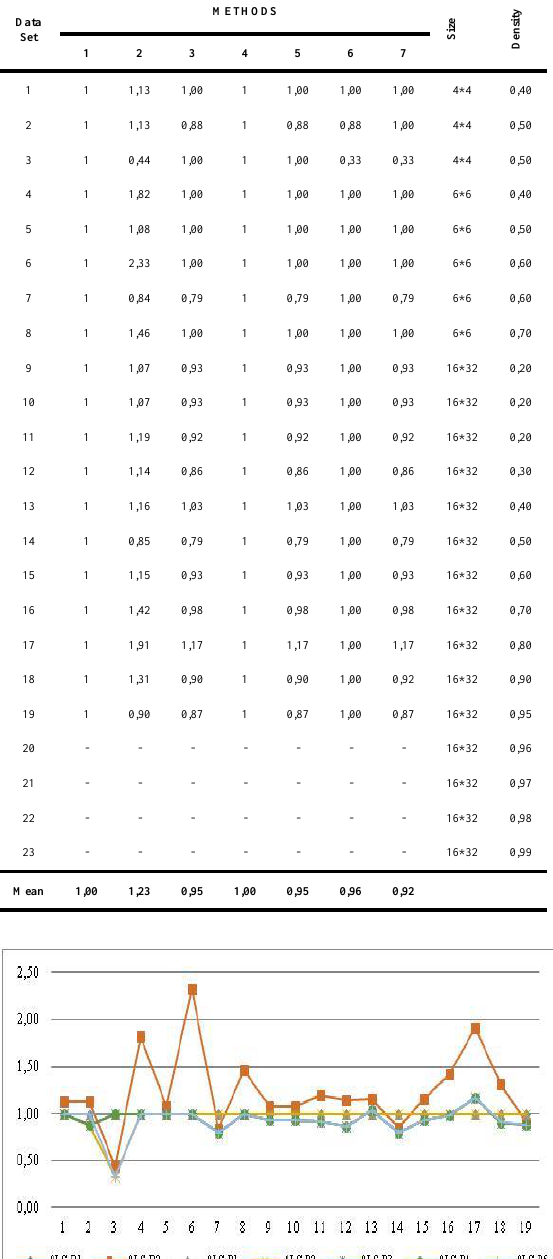
Table 4. Relative comparison of solution steps Data Set